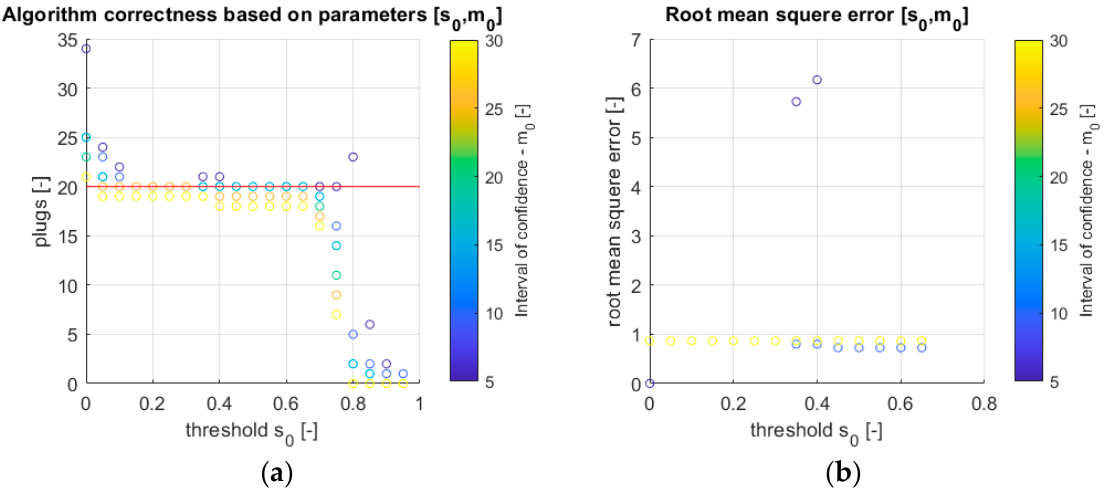
Figure 9. ( a ) Analysis of the influence of parameters s 0 , m 0 on the number of identifiable plugs (red line—expected value); ( b ) absolute error for the correlation function with respect to parameters s 0 , m 0 . The color of circles indicates the value of m 0 parameter (the scale is shown on the right hand).